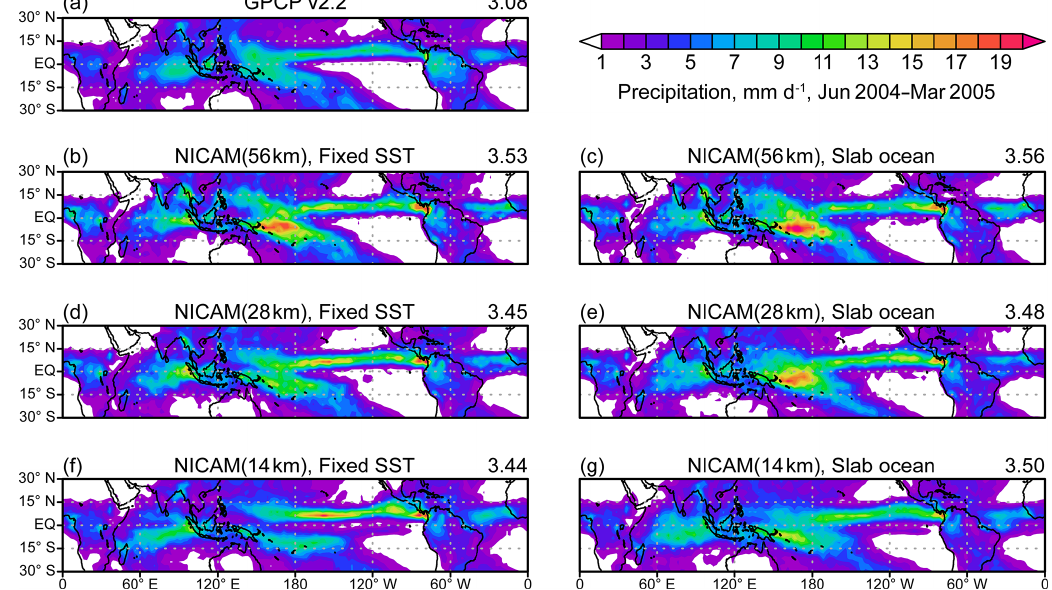
Figure 13. Annual mean precipitation during June 2004–May 2005 for the GPCP product (a) , the REFFIX runs (b, d, f) , and the REFSLB runs (c, e, g) . Results from NICAM16-7S (b, c) , NICAM16-8S (d, e) , and NICAM16-9S (f, g) are shown, and tropical mean precipitation is noted at the top-right corner of each panel.